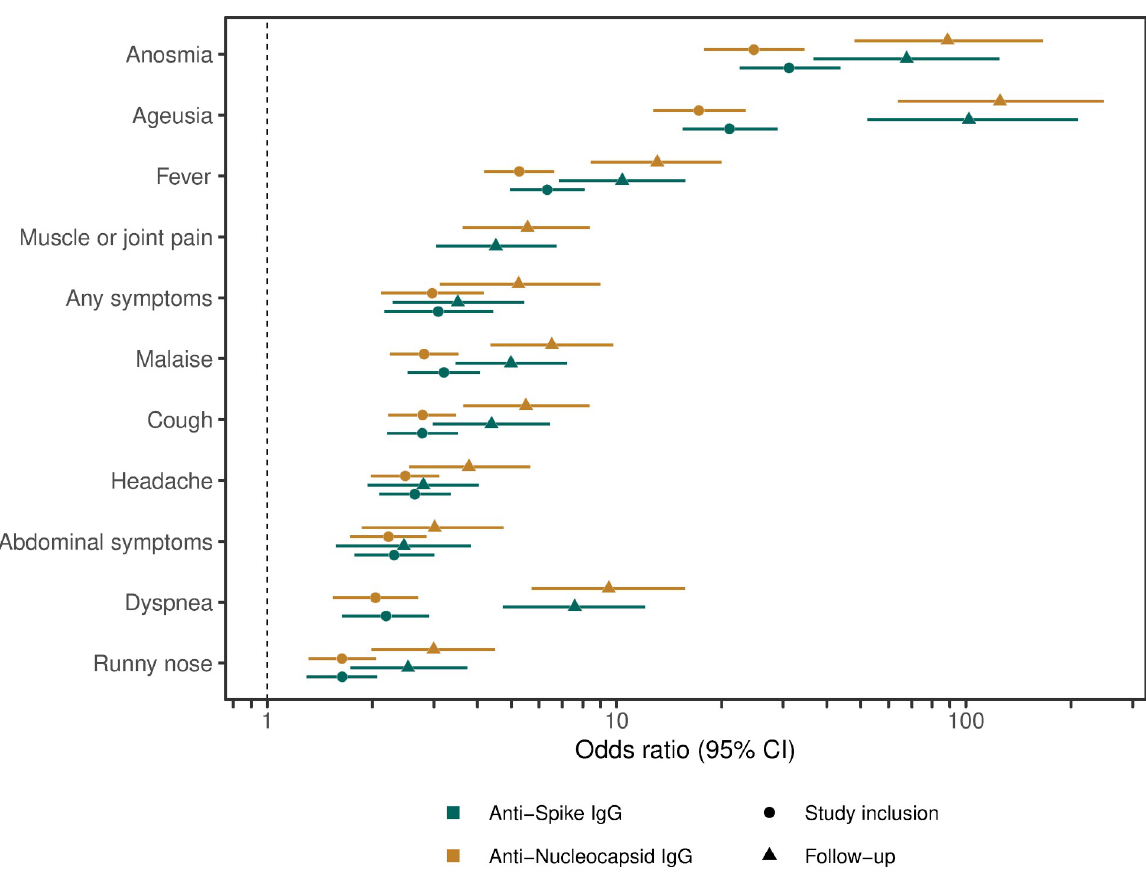
Fig 4. Seroconversion was associated with prior COVID-19 symptoms. Seroconversion to anti-spike IgG (green) and anti-nucleocapsid IgG (brown) prior to study inclusion (circles) and during the follow-up period (triangles) was associated with self-reported anosmia, ageusia, fever, muscle or joint pain, presence of any symptoms, malaise, cough, headache, abdominal symptoms, dyspnea, or runny nose. CI: Confidence Interval.